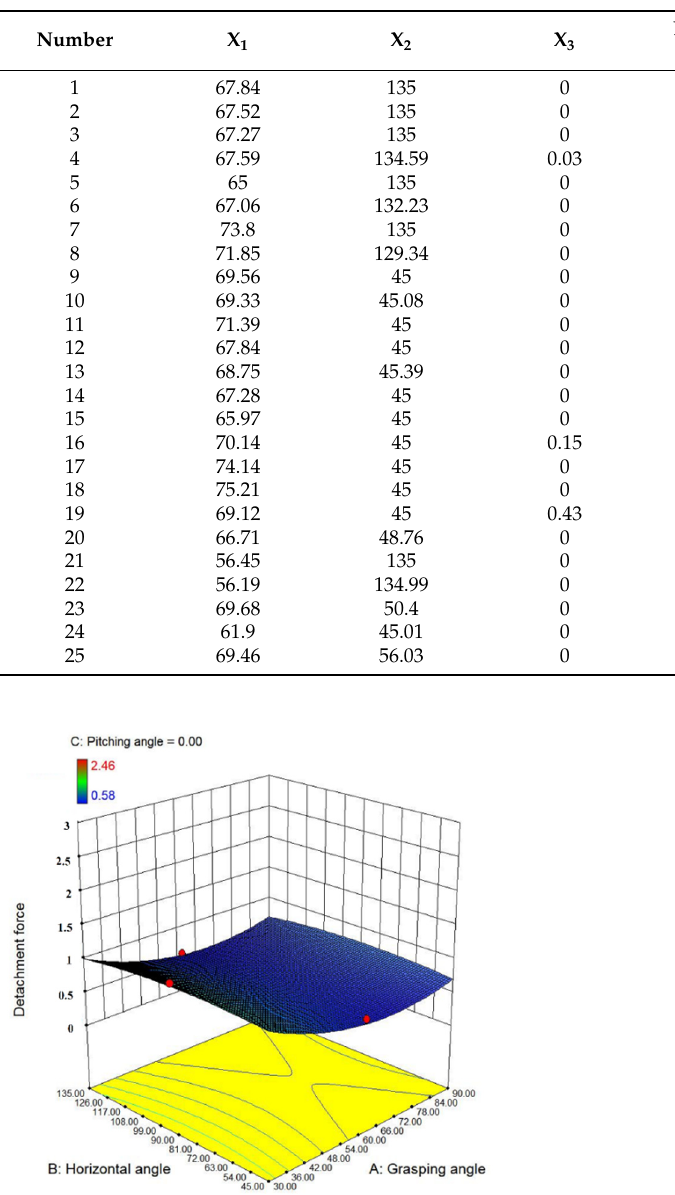
Table 5. Constraints of machine parameters and responses. Table 6. Optimal combination for detachment force for higher desirability.